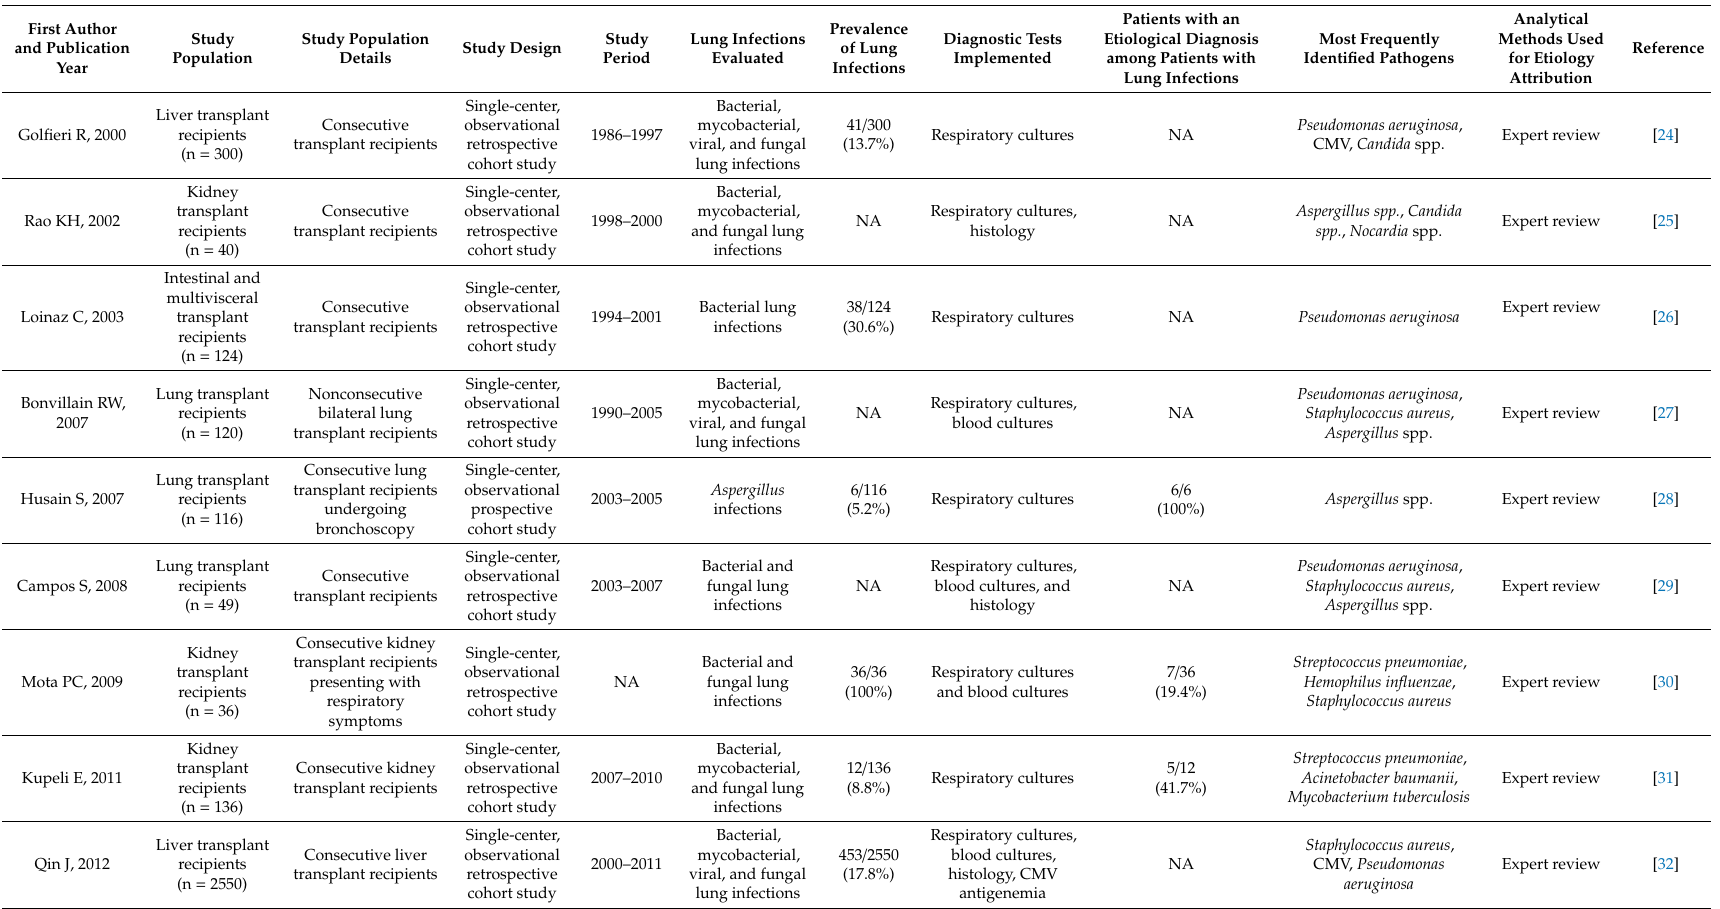
Table 1. Main studies addressing the etiology of lung infections in solid organ transplant